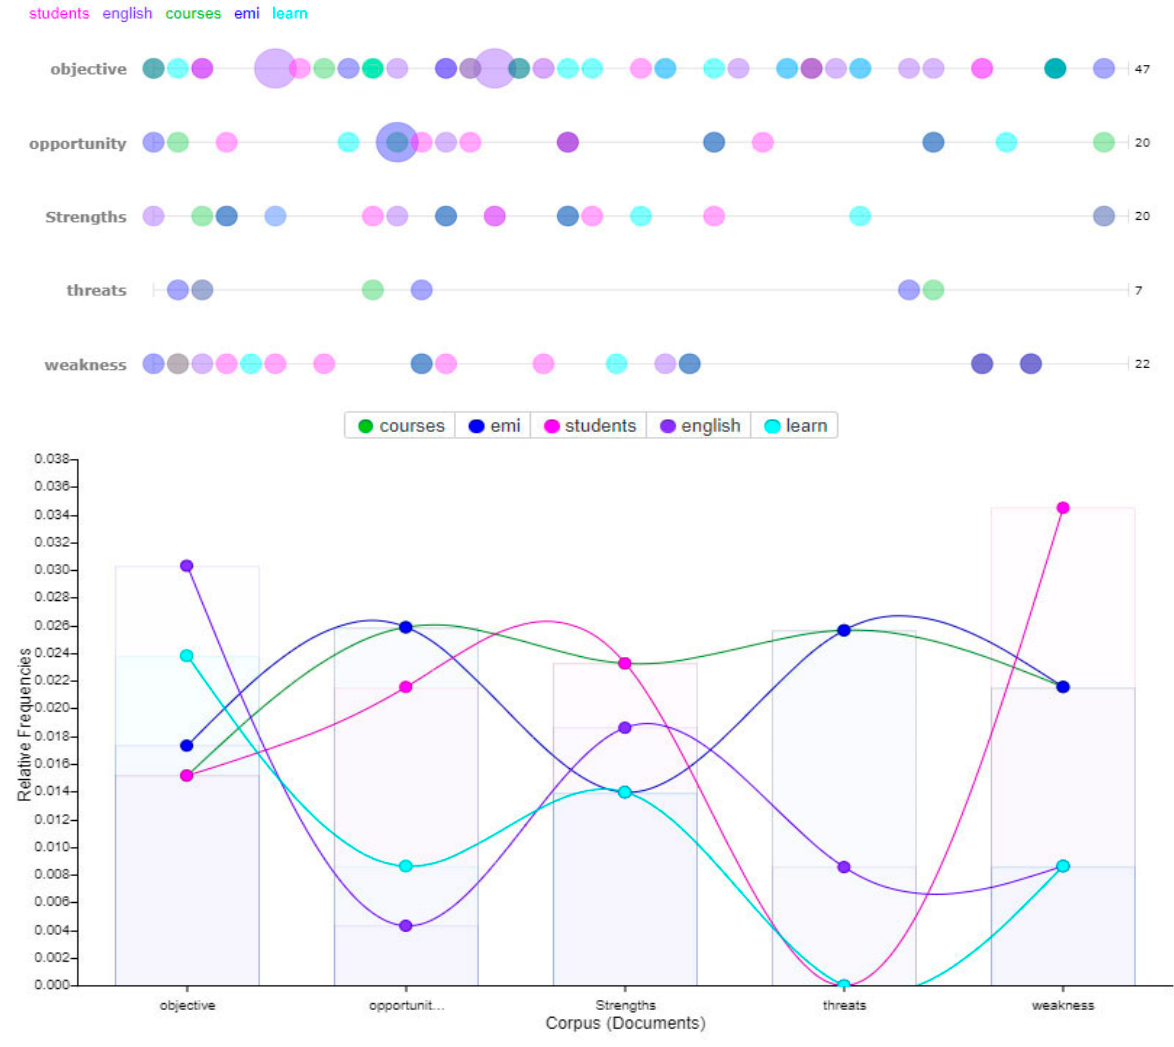
Figure 2. Graphical representation of the frequency of occurrence for the five main keywords.